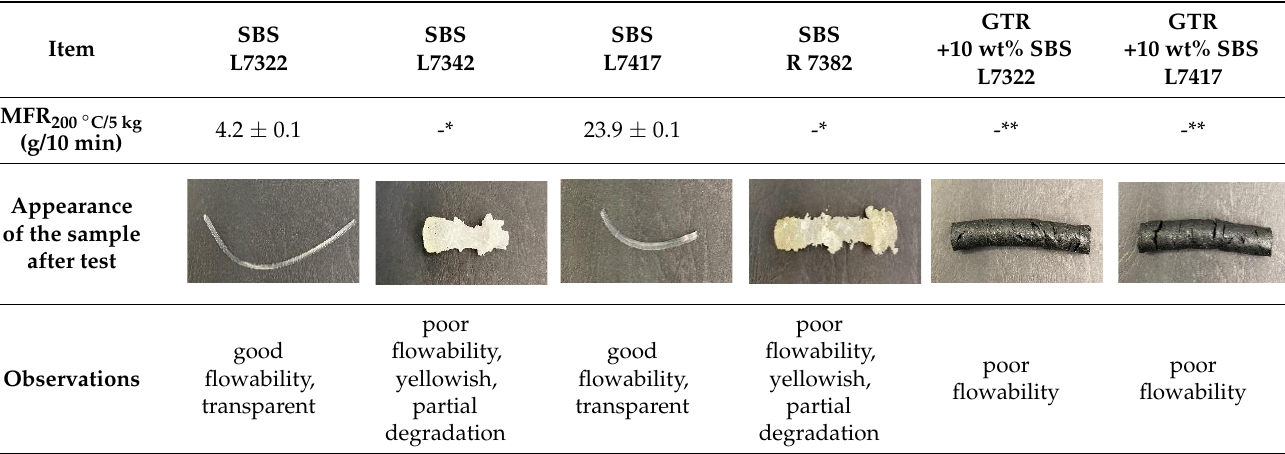
Table 1. MFR measurement results for SBS copolymers and GTR modified by SBS copolymers.